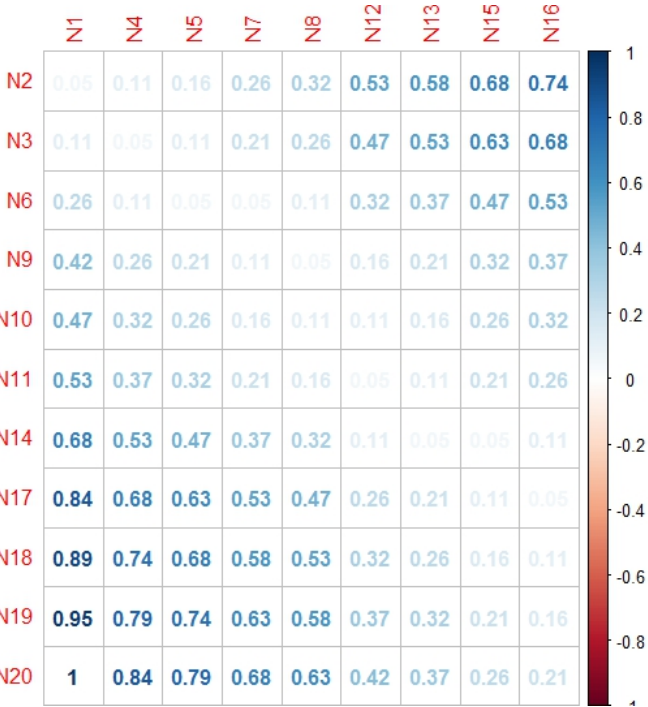
19 of 24 Figure 7. Statistical diagram of difference between the steady-state fleet size vector and the actual fleet size vector. In Figure 7, the horizontal axis represents the stations and the vertical axis represents the difference between the steady-state fleet size vector and the actual fleet size vector. 8. Construct the moving-out stations number vector and moving-in stations number vector. (1) Moving-out stations sequence vector 𝜔 = (2 3 6 9 10 11 14 17 18 19 20) (2) Moving-in stations sequence vector